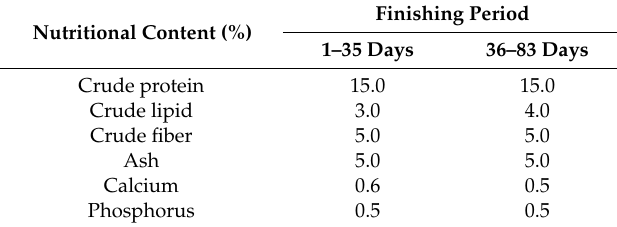
Table 2. Nutritional content of the feed used in this study (supplied over two